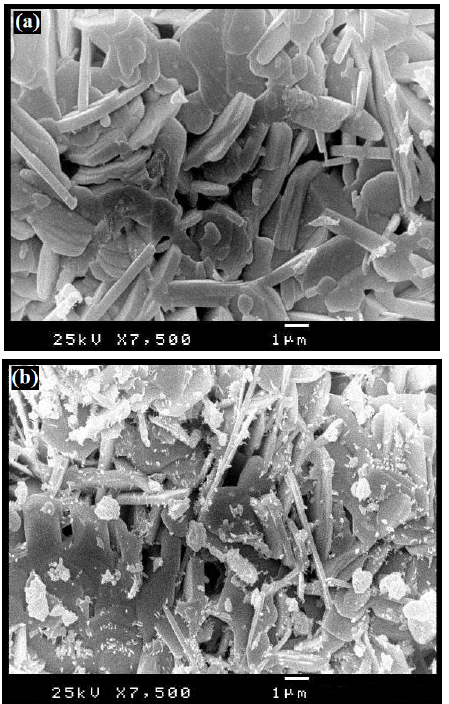
Fig. 3 SEM micrographs for (a) BiPb-2223 sample and (b) (BaSnO 3 ) 1.5wt% /BiPb-2223